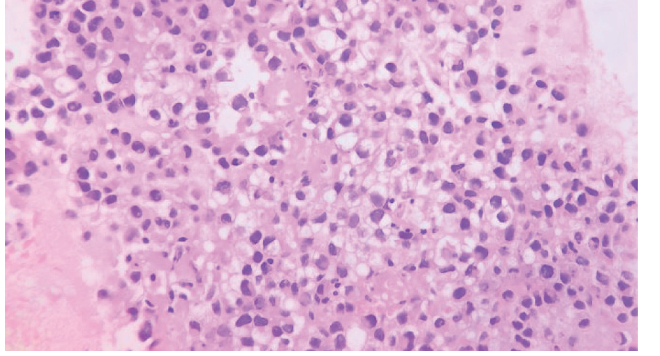
Figure 2A: Histopathology showing tumor cells in diffuse pattern exhibiting moderate pleomorphism, increased nuclear to cytoplasmic ratio and some macronucleoli,.